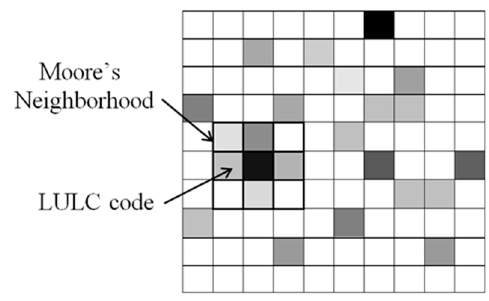
Figure 2. The cellular space and neighbors of simulated LULC change.